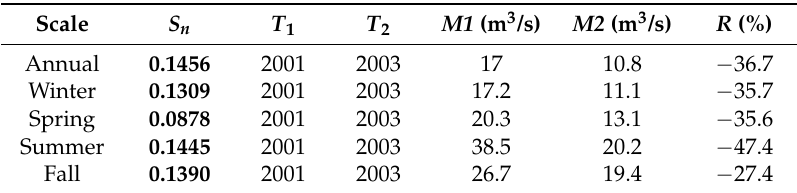
Table 3. Analysis of the temporal variability of annual and seasonal minimum daily flows from 1980 to 2014 using the Lombard method.